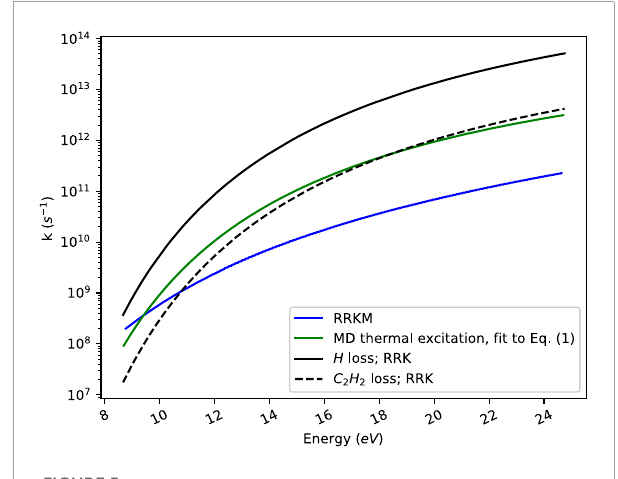
FIGURE 5 Illustration of RRKM, ReaxFF MD with thermal excitation, and RRK modelled microcanonical rate constants.